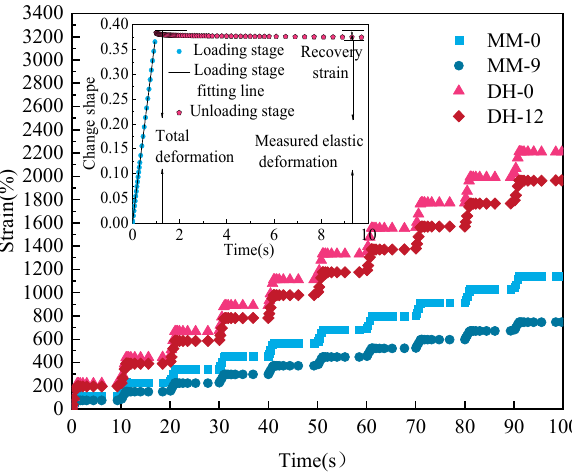
Figure 5. Burgers Model–Creep Test Diagram and Creep Recovery Diagram. Under the same stress and temperature, the creep cycle data from the 1st to 100th times were fitted for two asphalts with different aging degrees, with an interval of 10 times. As seen in Figures 6 and 7, the G v values of the Donghai and Maoming binders had different changes in different aging degrees after adding lignin, which was long-term aging > short- term aging > before aging. This demonstrated that the addition of lignin can significantly improve the high-temperature resistance of asphalt. The G */sin δ and G v values were consistent in evaluating the high-temperature performance of lignin-modified asphalt, but there were differences in the evaluation conclusions between different modified asphalts. two matrix asphalt components.